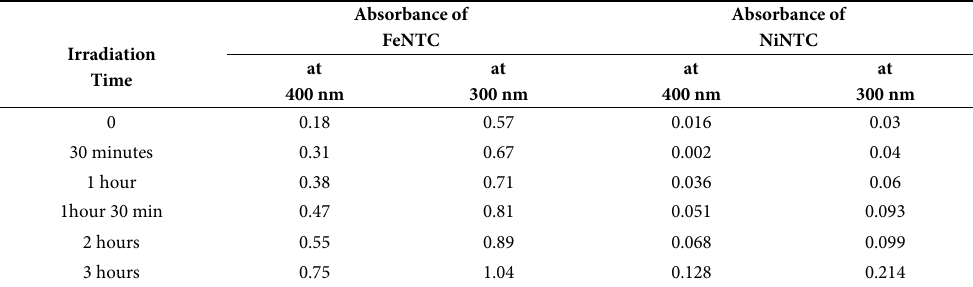
Table 1. Comparison of absorbance of FeNTC and NiNTC under light